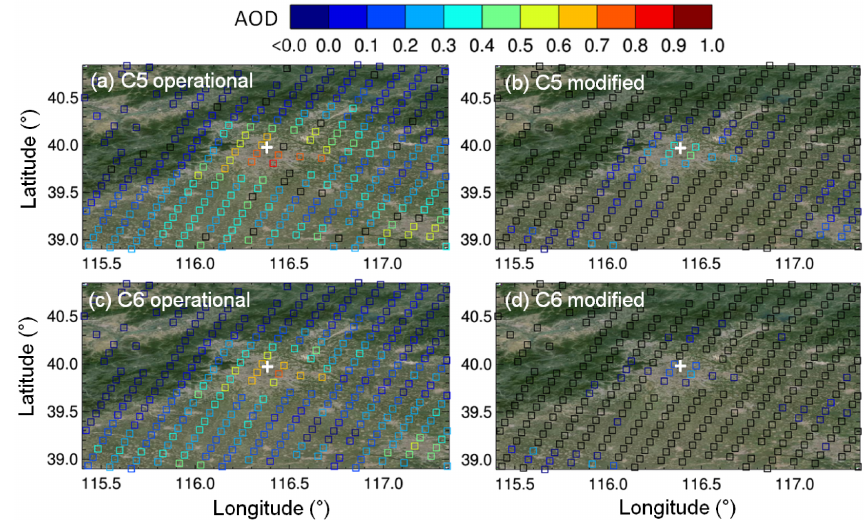
Figure 6. Distribution of AOD over Beijing area on 17 May 2012, derived from MODIS measurements by (a) operational C5 method, (b) modified C5 method, (c) operational C6 method, and (d) modified C6 method. Corresponding AOD from AERONET (Beijing, white cross) was 0.55.